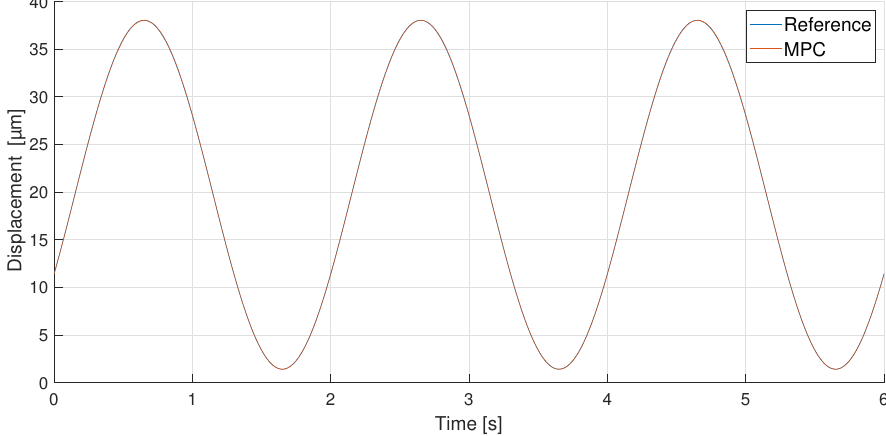
Figure 20. Tracking results of the MPC for a 0.5 Hz sinusoidal